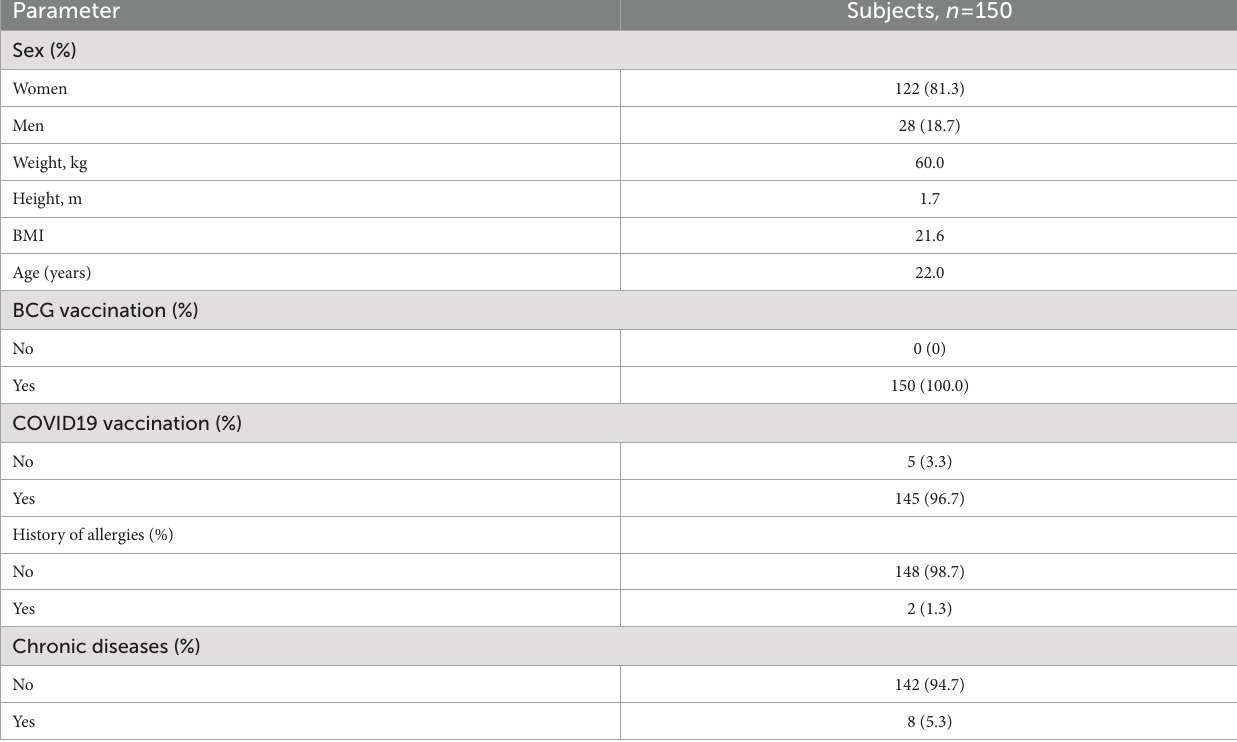
TABLE 2 Characteristics of subjects included in the